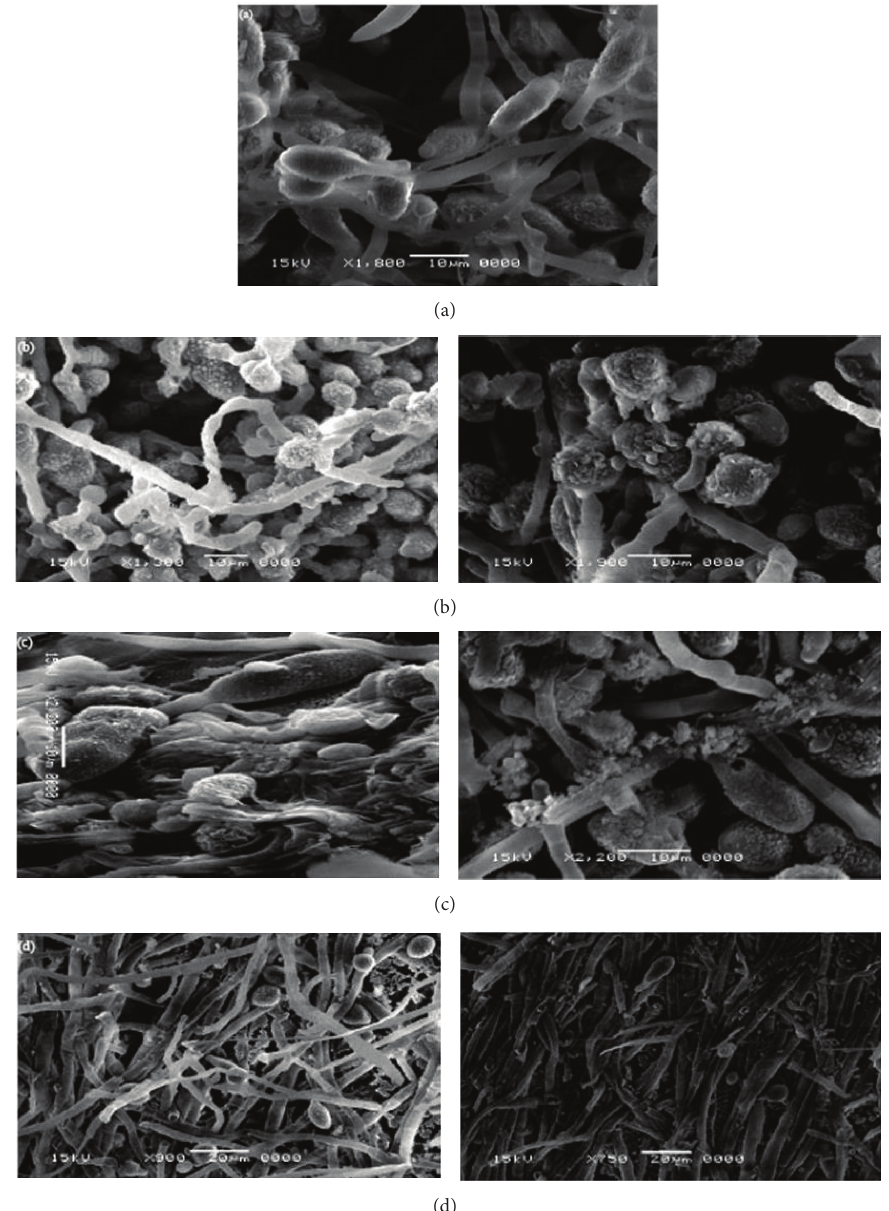
Figure 8: Antifungal effect of Ag nanoparticles on culture filtrate and cell. Scanning electron microscopy images of hyphae of Alternaria alternata treated with silver, copper, or copper/silver nanoparticles. Fungal hyphae grown on potato dextrose agar plates as (a) control or supplemented with 15mgL −1 , (b) Ag, (c) Cu, or (d) Ag/Cu nanoparticle solution, respectively, Photos were taken at seven days after the incubation period